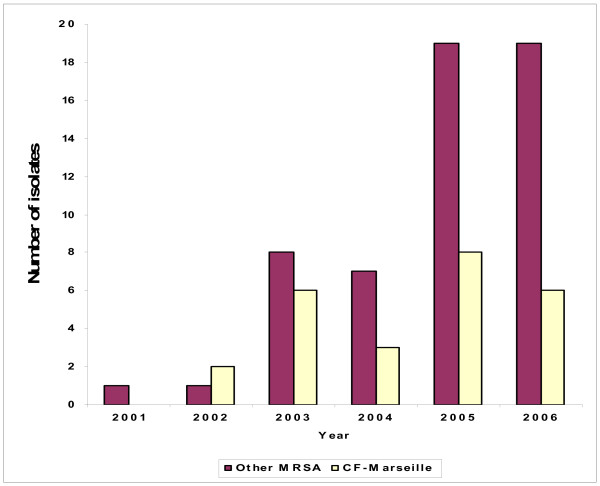
Repartition of CF-Marseille phenotype among MRSA per year.